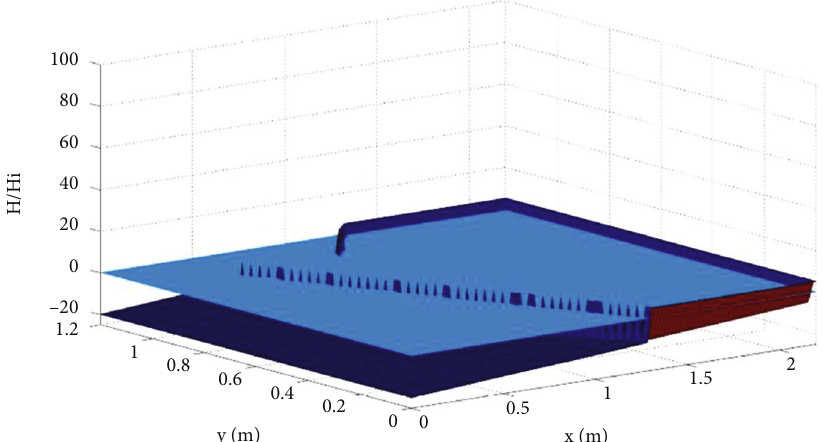
Figure 2: Numerical grid of Sato et al. ’ s [27] model.